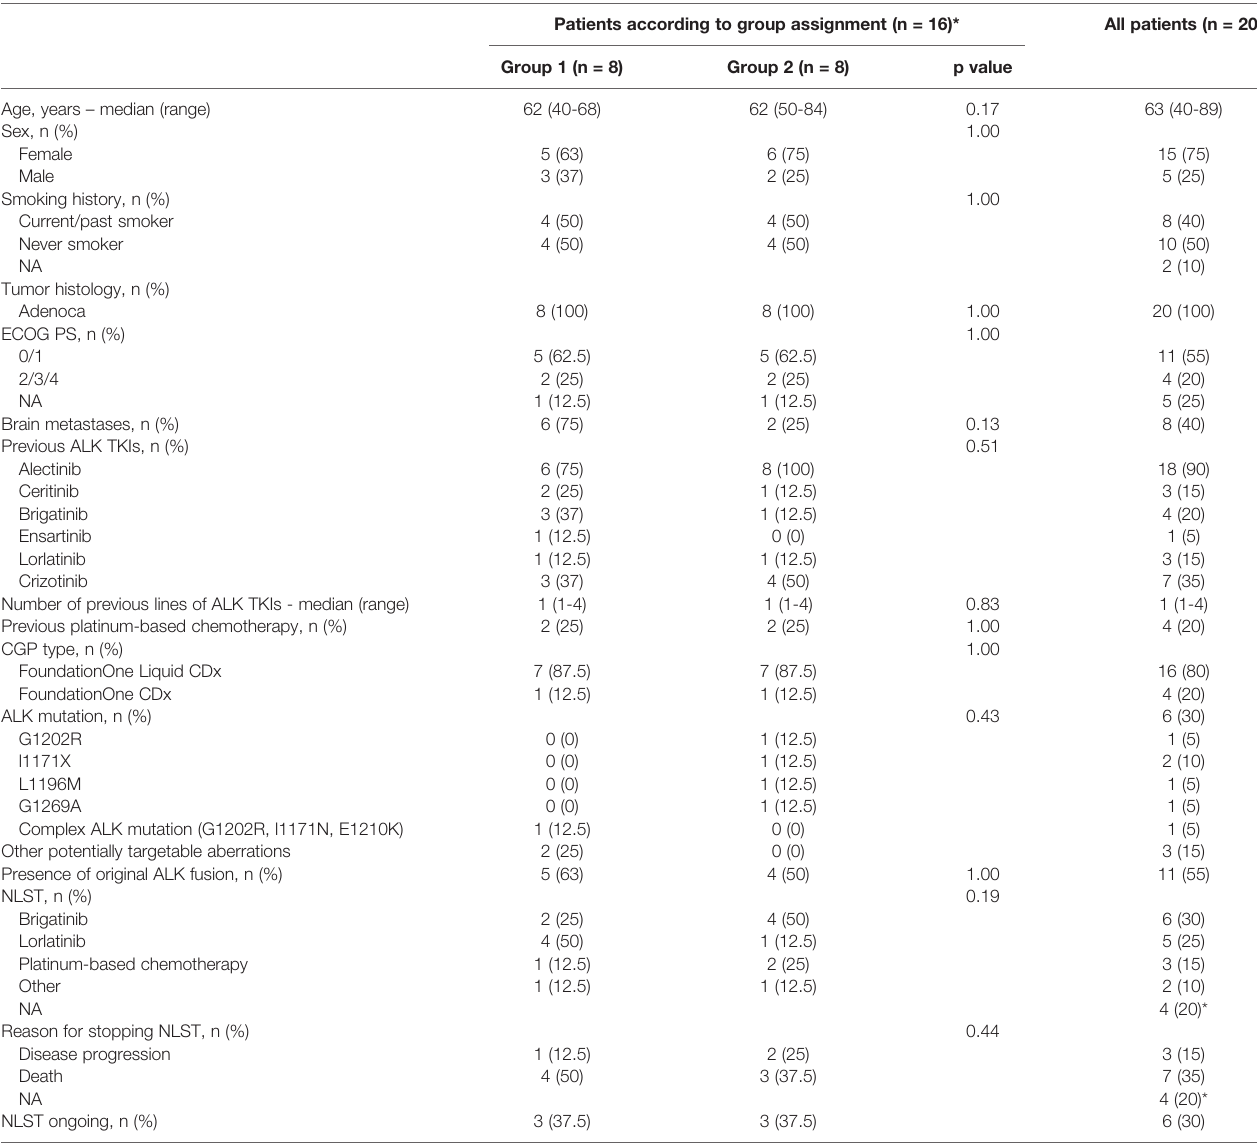
TABLE 1 | Patient baseline and treatment characteristics in the whole study population and according to whether NLST was initiated before (group 1) or after (group 2) receival of CGP results. Patients according to group assignment (n =